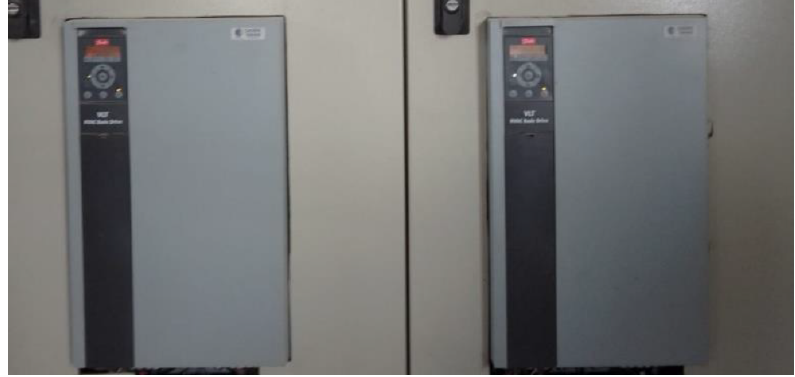
Figure 12. Frequency converters. Source: